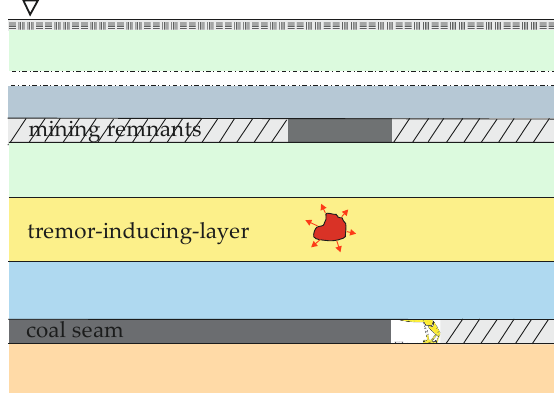
Figure 1. Schematic diagram of mining remnants and tremor-inducing layer.